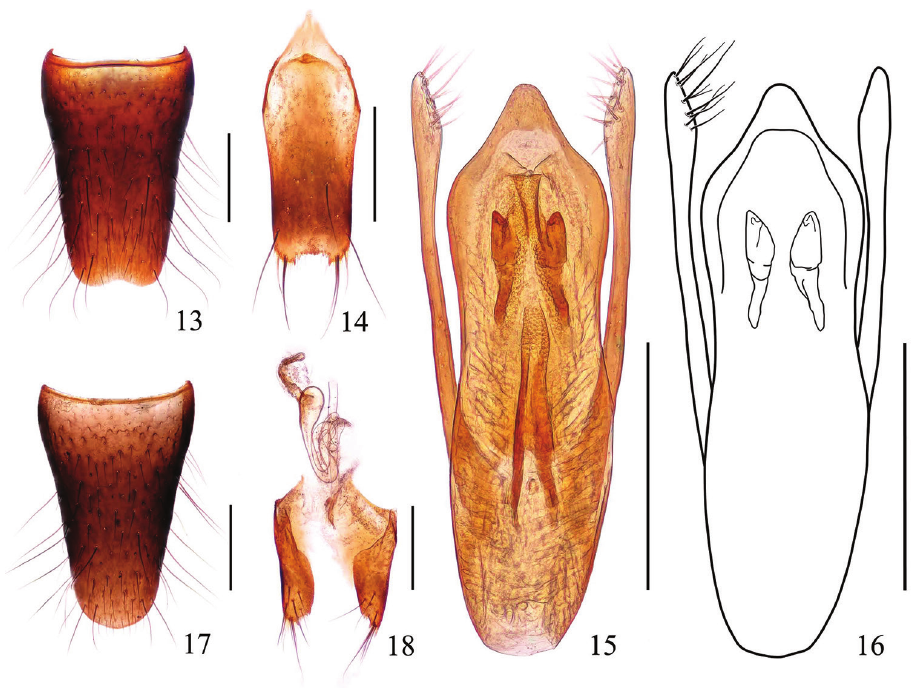
17 female sternite VIII 18 valvifers and spermatheca. Scale bars: 0.25